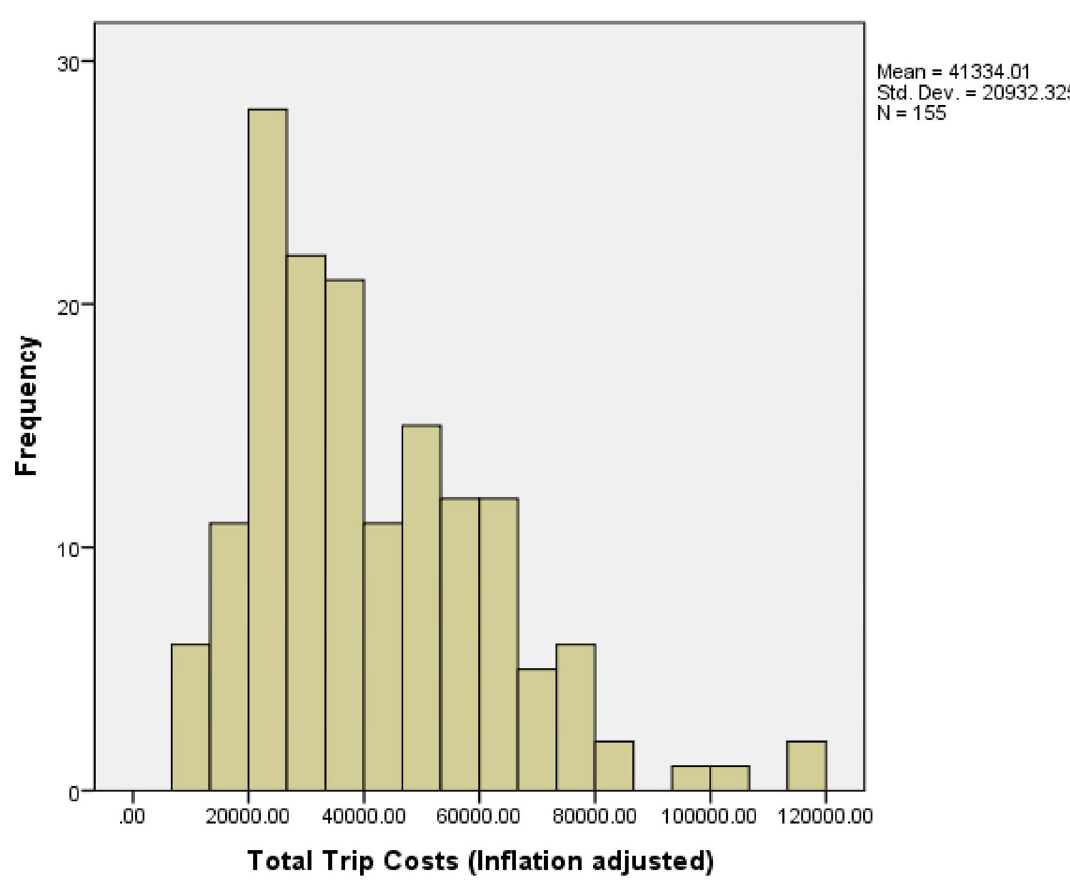
Fig 3. Histogram of total trip costs for sampled trips in American Samoa longline fishery: 2006–2018.